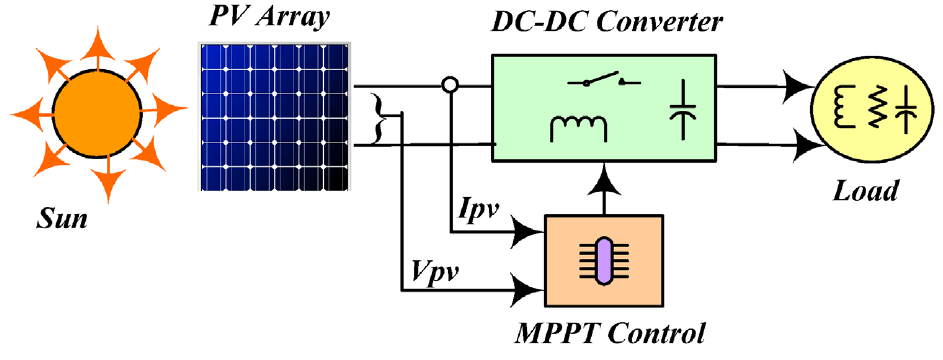
Figure 1. Block diagram of the PV energy system [37].